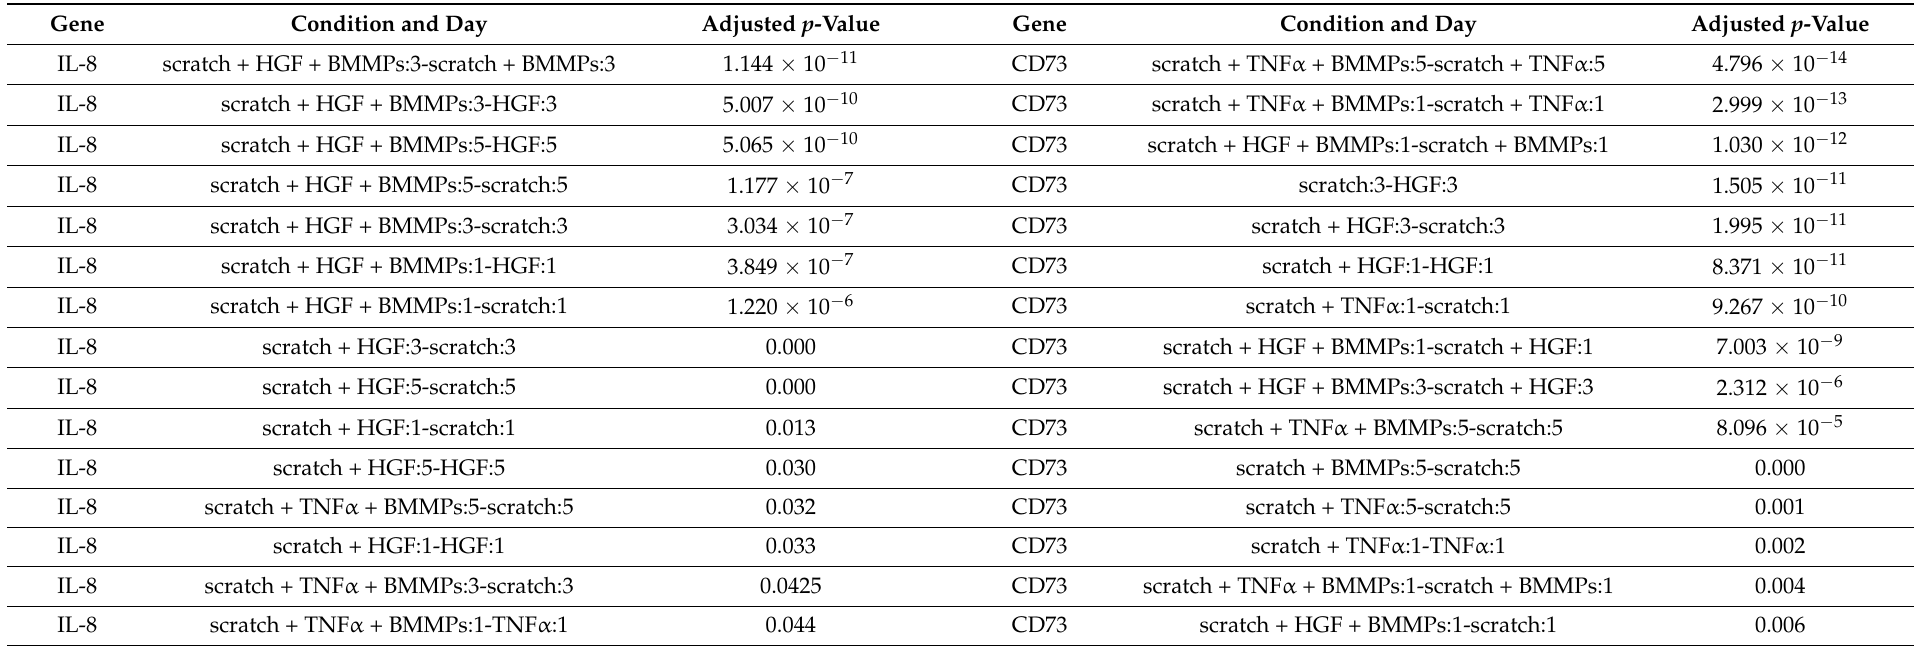
Table 1. The most statistically significant conditions plus time points for IL-8 and CD73